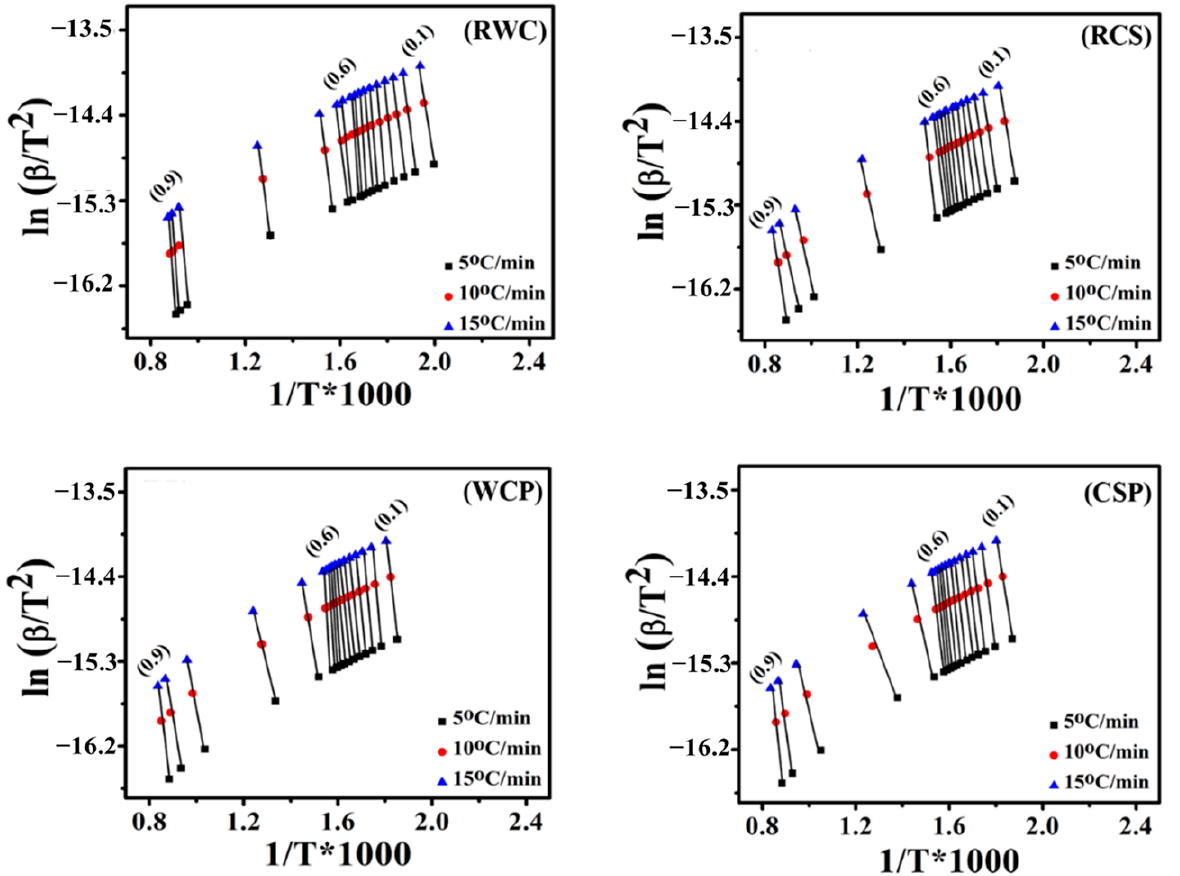
Figure 4. Arrhenius plot of the DAEM method at the selected ( α ) for raw materials and pellets.